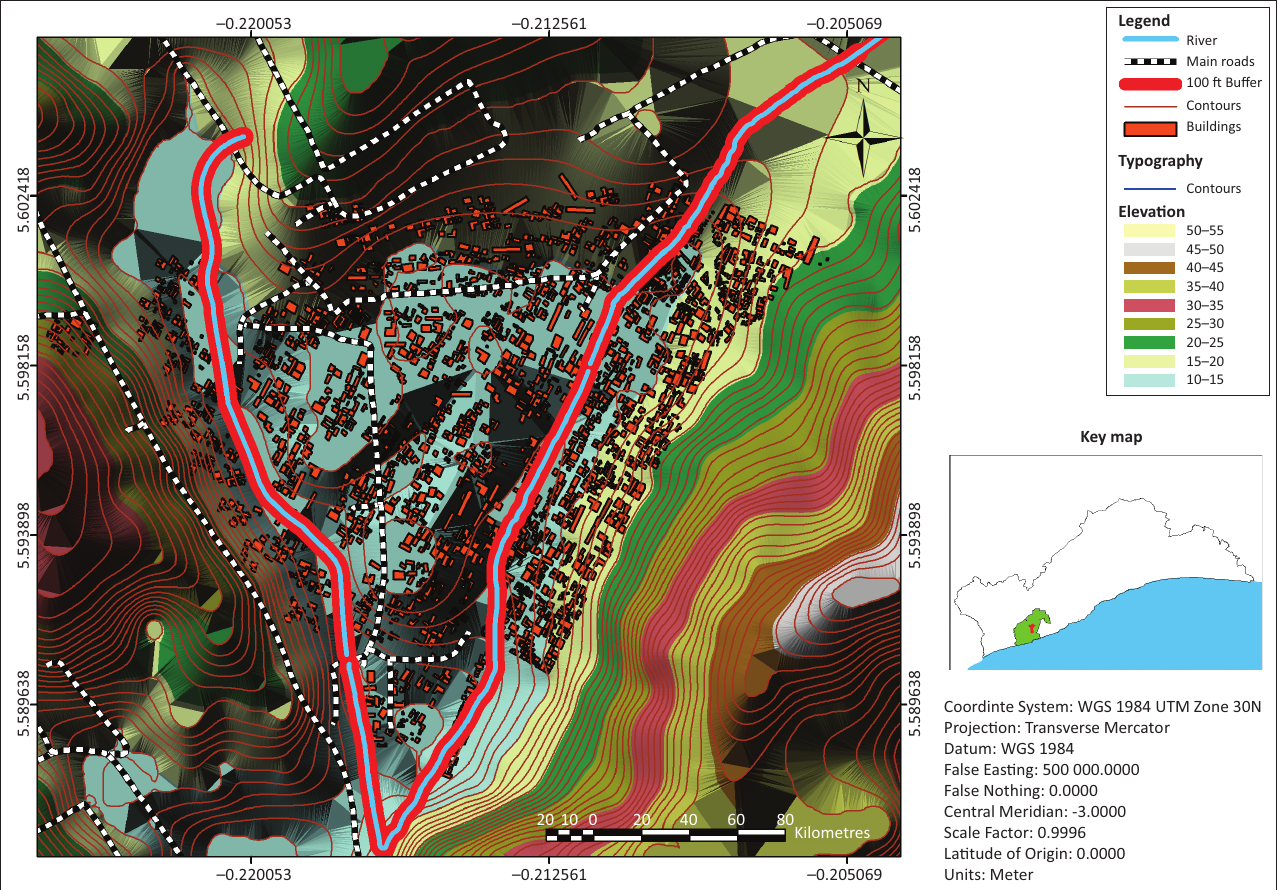
FIGURE 5: Degree of flood exposure of Alajo using triangular irregular